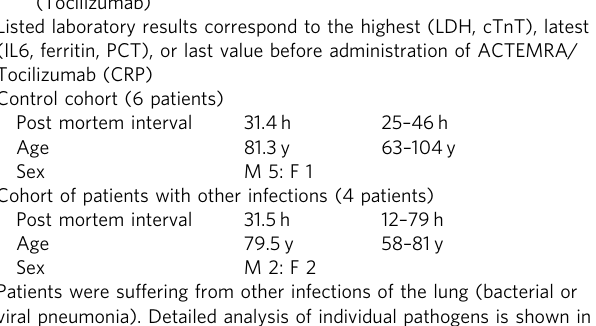
viral pneumonia). Detailed analysis of individual pathogens is shown in Fig.